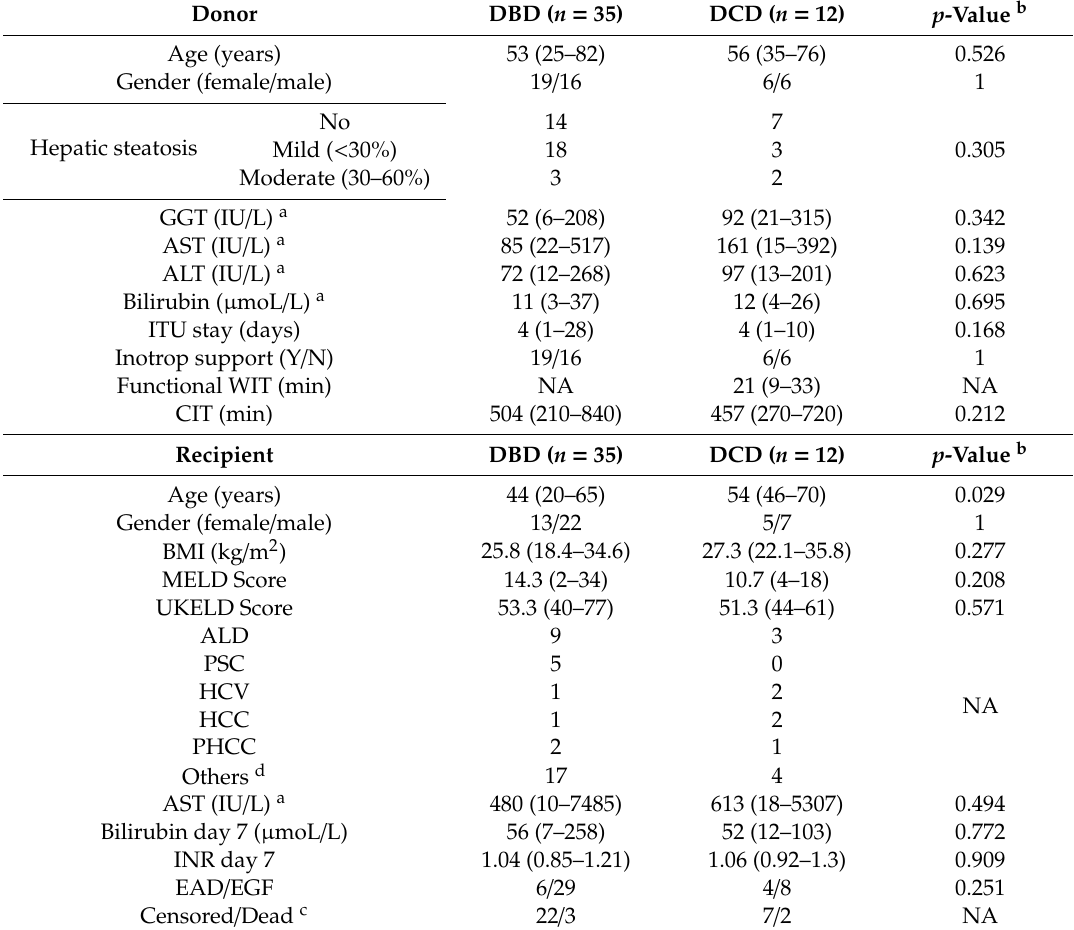
Table 1. Demographic characteristics and clinical data of the 94 subjects involved in this